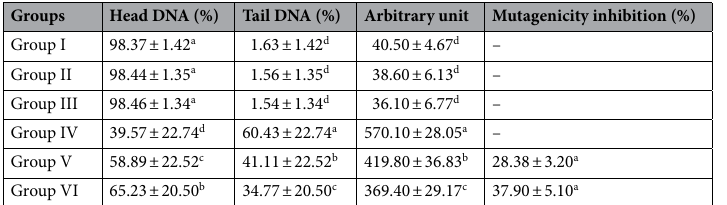
Table 5. Detection of the effects of penoxsulam and BBE applications on DNA by comet assay. Group I: tap water (control), Group II: 25 mg/L BBE, Group III: 50 mg/L BBE, Group IV: 20 μg/L penoxsulam, Group V: 20 μg/L penoxsulam + 25 mg/L BBE, Group VI: 20 μg/L penoxsulam + 50 mg/L BBE. Data are shown as mean ± standard deviation (SD). The averages shown with different letters in the same column are statistically significant (P < 0.05).